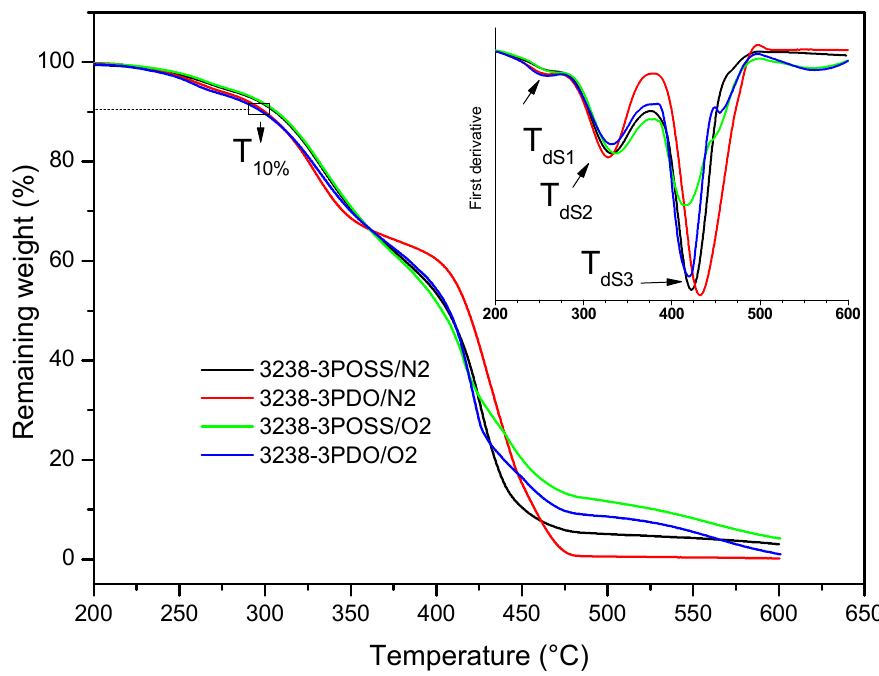
Figure 10. TGA thermograms of experiments 3238-3POSS and 3238-3PDO under a nitrogen atmo- sphere (/N2) and under an air atmosphere (/O2). DTGA curves are shown in inset graph.